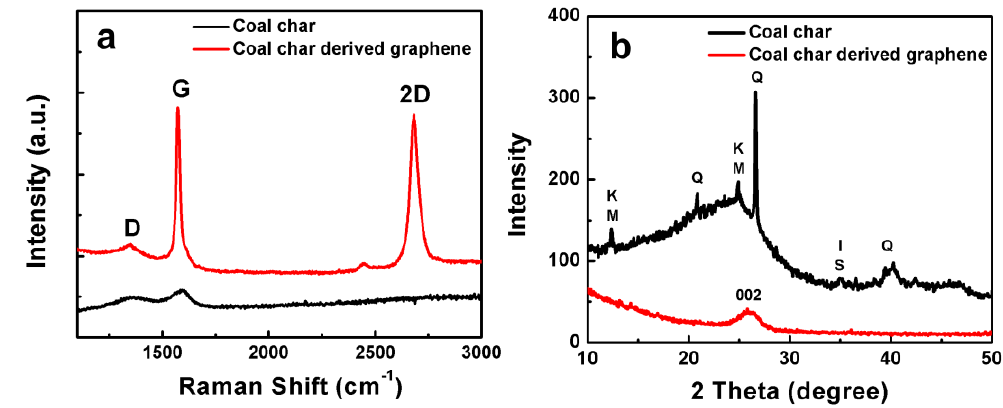
Figure 2. Raman spectra ( a ) and XRD patterns ( b ) of coal char derived graphene (red curve) and coal char (black curve).